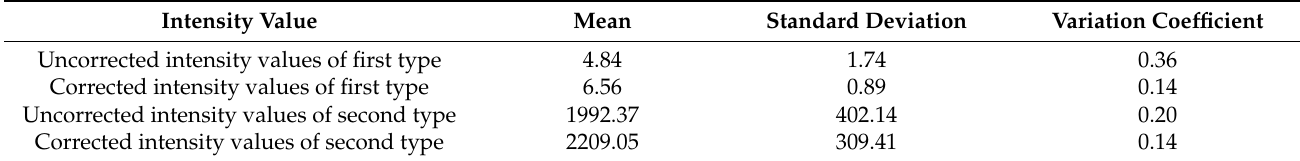
Figure 9. Results for strip 1: ( a ) the original intensity values (the reflectance); ( b ) the corrected intensity values by eliminating the effects of incident angle. Table 2. Intensity of mean, standard deviation and variation coefficient before and after correction for flight strip 1.